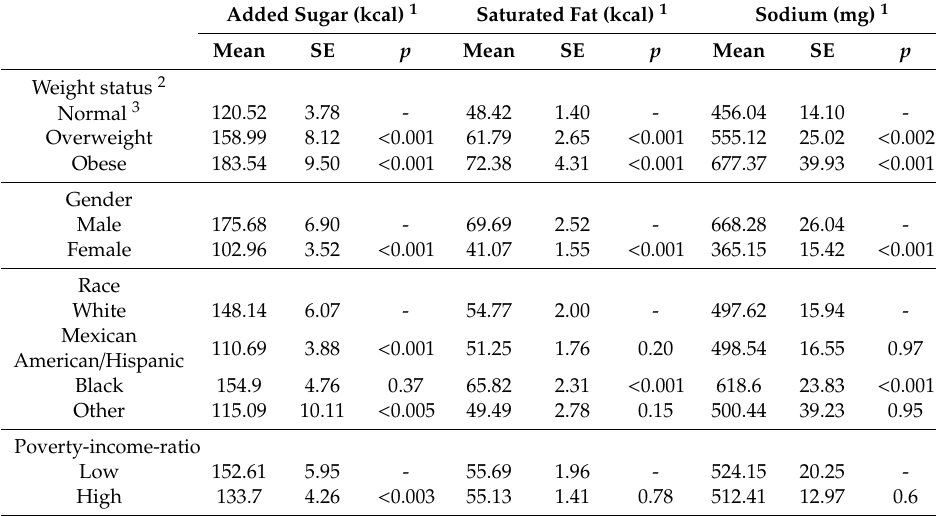
Table 3. Mean daily intake of added sugar, saturated fat, and sodium from snacks by adolescent demographic characteristics ( n =